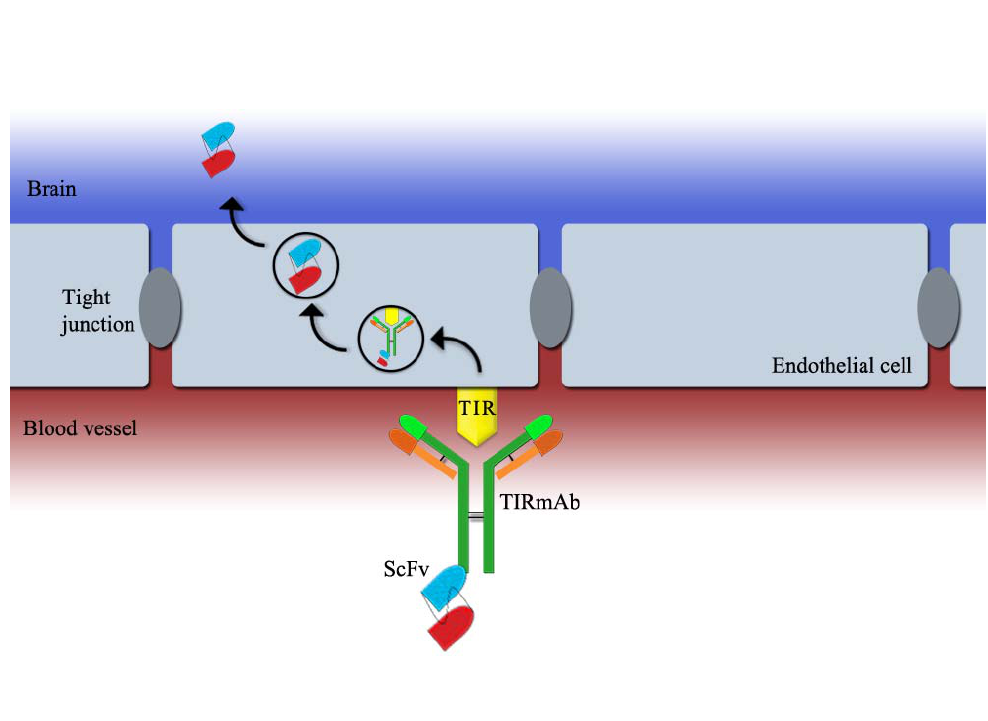
Figure 3. The scFv fragment is linked to the carboxy terminus of an antibody targeting the transferrin receptor (TIR), which is highly expressed by endothelial cells. The scFv crosses the blood-brain barrier through receptor-mediated